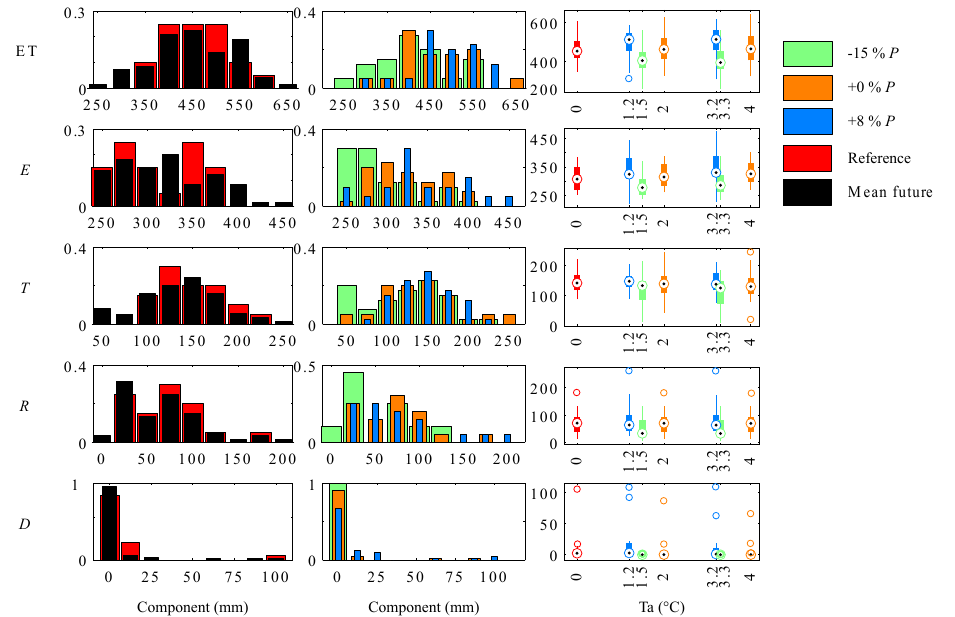
Figure 2. Simulation results for the annual components of the water cycle (Top to Down: ET, E , T , R and D ). Left: frequency histograms for reference (Sc0) and scenario-averaged future climatic scenarios (Sc1–Sc6). Middle: frequency histograms for the three precipitation periods. Right: boxplots of annual components of the water cycle as a function of temperature scenarios. Water cycle components correspond to x axis in the left and middle columns, and to y axis in the right